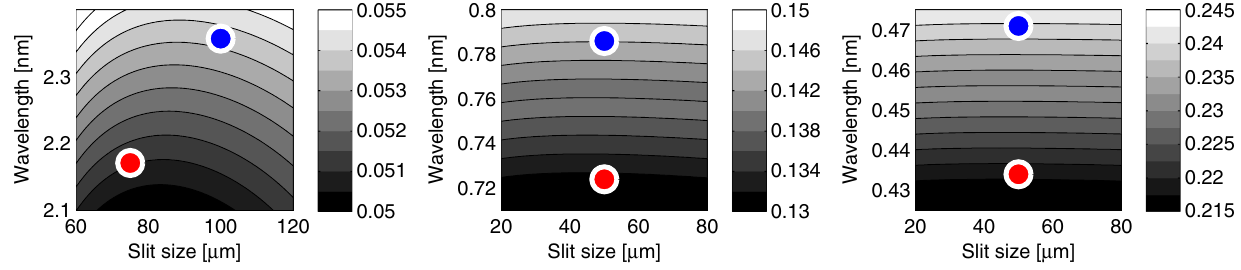
FIG. 7. Expected spectral resolution (color coded) as a function of wavelength and slit size as discussed in the setup section. The red and blue dots mark the chosen slit width for the warm and the cold undulator spectrum measurement, respectively. From left to right the best spectral resolution according to the wavelengths of the fundamental, third, and fifth harmonic is shown. The higher harmonics intrinsic undulator bandwidth of 1.67% and 1% for the third and the fifth harmonic, respectively is overlaid by the spectrometers resolution and thereby not